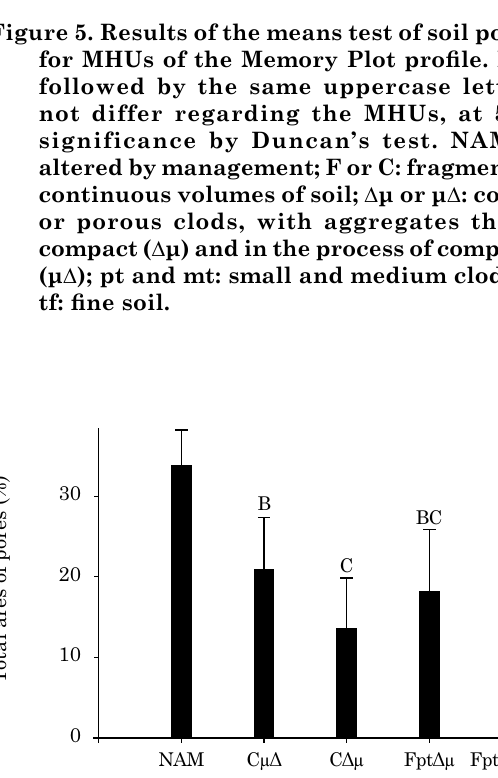
Figure 5. Results of the means test of soil porosity for MHUs of the Memory Plot profile.